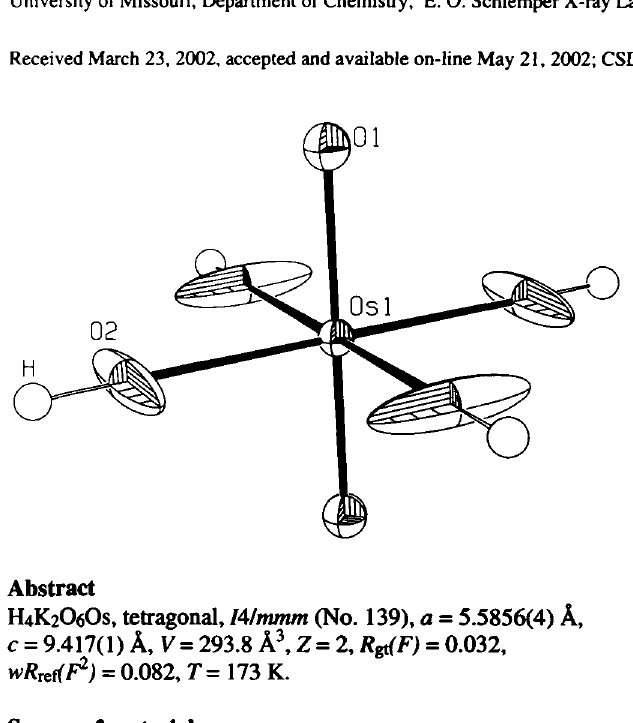
Table 1. Data collection and handling. Crystal: